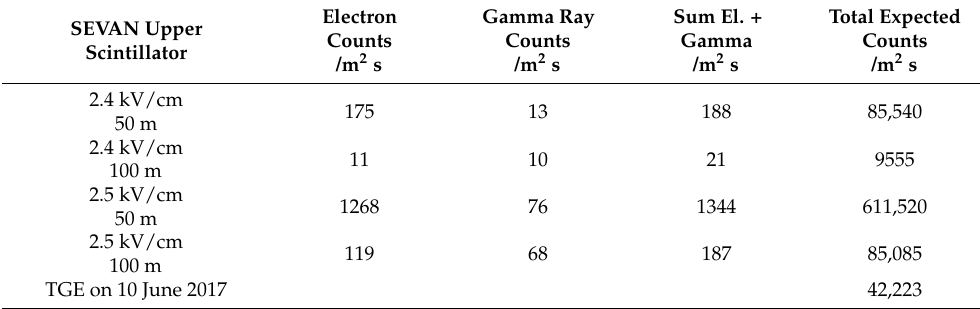
Table 5. Expected SEVAN upper detector count rates (modeled counts multiplied by registration efficiencies, per seed electron, per second) at Lomnicky Stit for different electric fields, and the measured count rate of the upper SEVAN scintillator at 13:14, 10 June 2017 (last row). In the previous column, simulated counts are multiplied by the number of seed